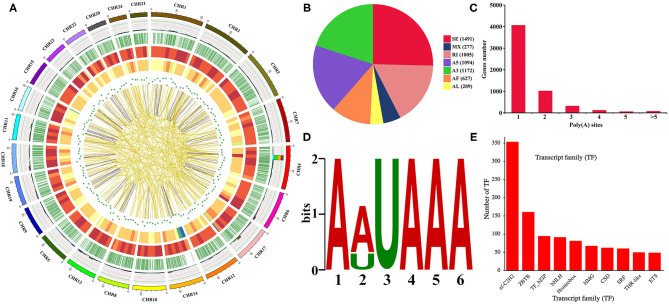
Gene structure analysis. (A) Circos visualization of Iso-Seq data at the genome-wide level. From the outside to the inside: 1. Chromosome sequence. 2. Accumulation histogram of alternative splicing events (light blue indicates RI, green indicates A3, yellow indicates A5, purple indicates SE, red indicates MX, brown indicates AF, and dark blue indicates AL). 3. Alternative polyadenylation sites. 4. Distribution of novel transcripts from Iso-Seq. The color closer to red represents higher density, and the color closer to blue represents lower density. 5. Distribution of novel genes from Iso-Seq. The color closer to red represents higher density. 6. LncRNA density. The dot closer to the center represents lower density. 7. Linkage of fusion transcripts. Purple indicates intrachromosomal, and yellow indicates interchromosomal. (B) Statistics of alternative splicing events. (C) Statistics of alternative polyadenylation events. (D) MEME analysis of motif upstream of the poly(A) site. (E) Transcription factor analysis.